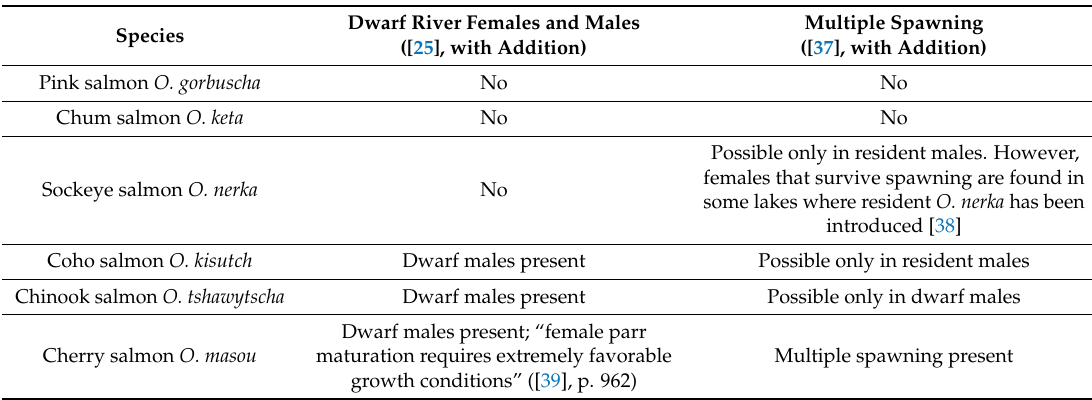
Table 2. Characteristics of species of the genus